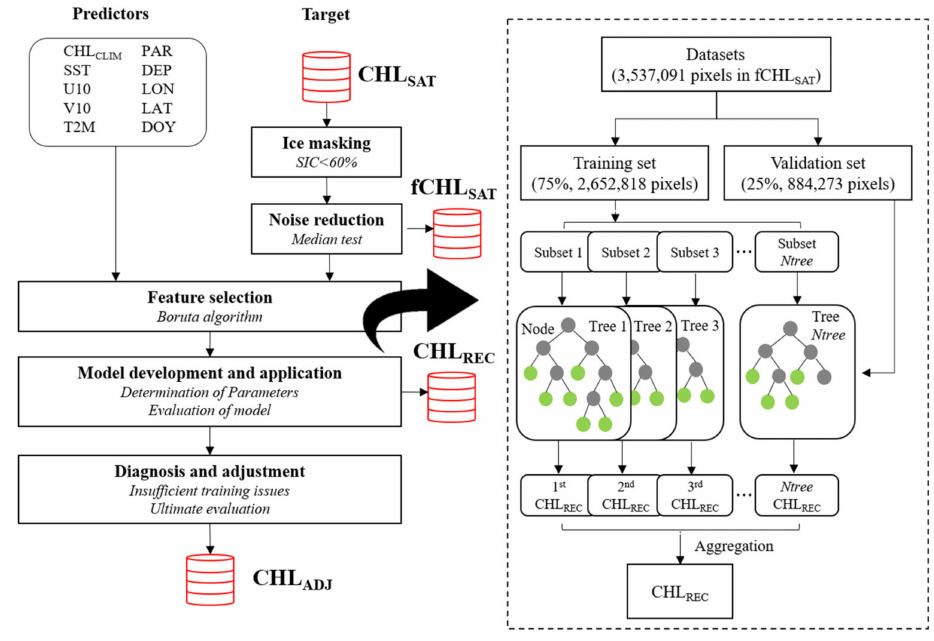
Figure 2. Flowchart to illustrate the fundamental process conducted in this study (left) and the schematic diagram of the random forest (RF) model used for the CHL reconstruction. CHL SAT data from which noise is removed through the median test method are specified as “fCHL SAT ”. “CHL REC ” refers to the CHL data produced primarily through the RF model and then the RF model was adjusted due to insu ffi cient training issue (final product is labeled “CHL ADJ